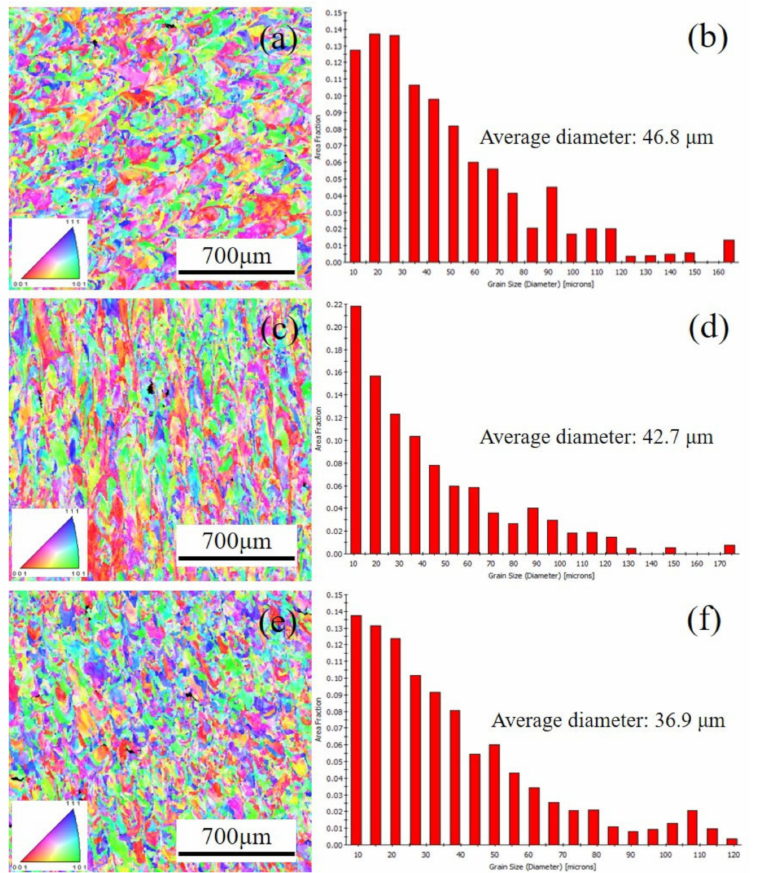
Figure 8. Grain orientation and size distribution of HTed GH3536 before heat treatment: ( a , b ) transverse sample; ( c , d ) longitudinal sample; and ( e , f ) 45 ◦